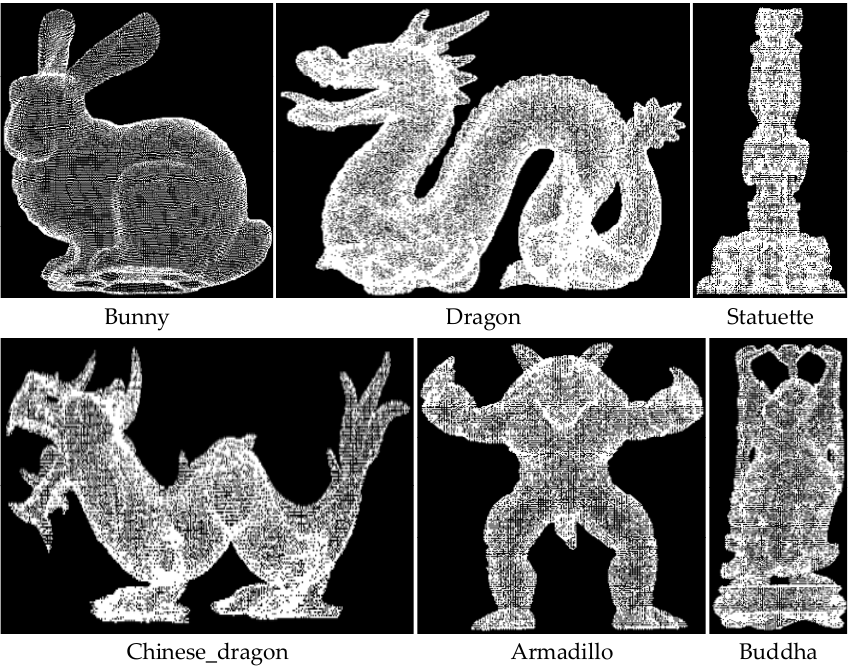
Figure 9. The model point cloud data set. The data set includes six point cloud models, namely, Bunny, Dragon, Statuette, Chinese_Dragon, Armadillo, and Buddha.